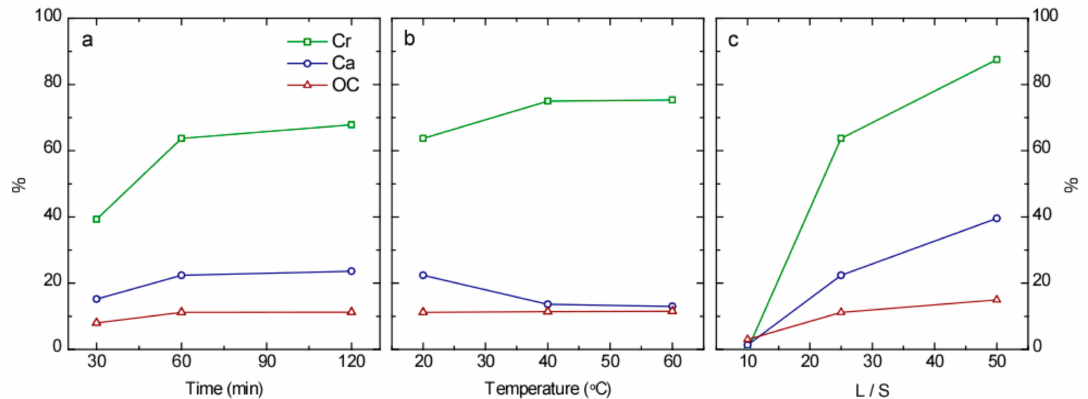
Figure 2. ( a ) Cr(III), ( b ) Ca, and ( c ) organic carbon (OC) leachability from tannery sludge under various experimental conditions (i.e., contact time, temperature, L / S / ratio) by applying 0.4 N H 2 SO 4